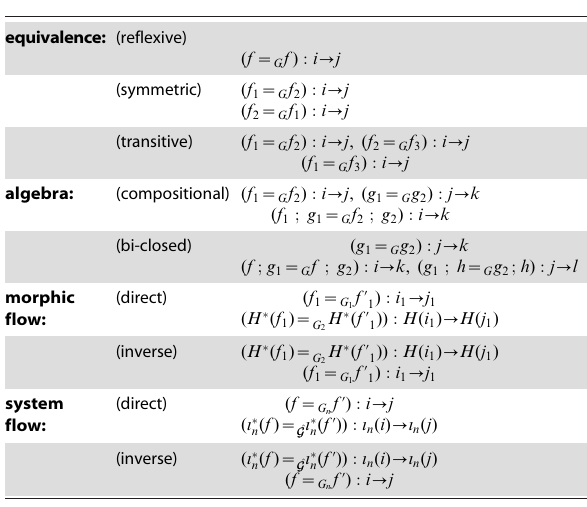
Table 1. Inference